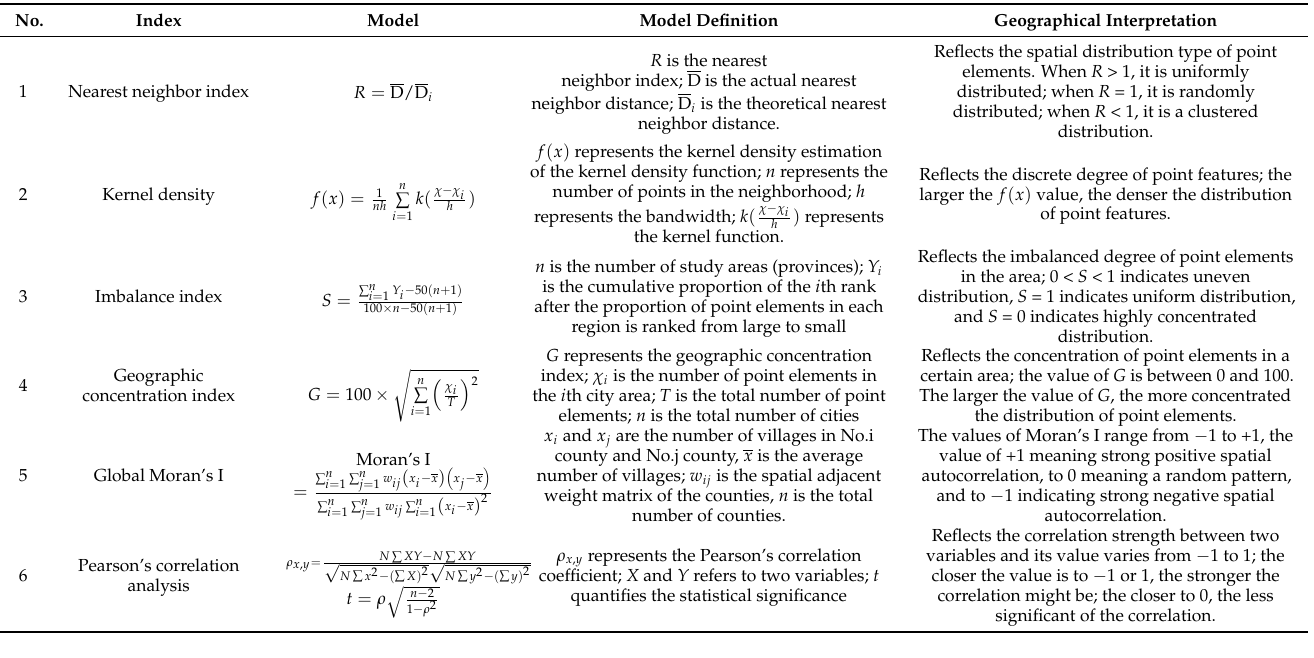
Table 2. Analytical models and interpretations.